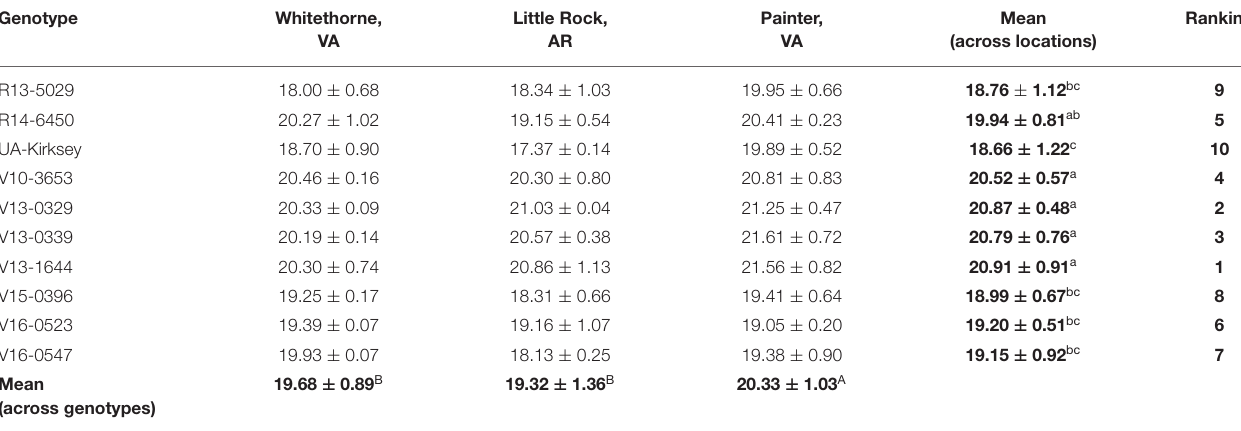
TABLE 7 | Oil contents (%, d.b.) of 10 edamame genotypes planted in different locations. Genotype Painter,